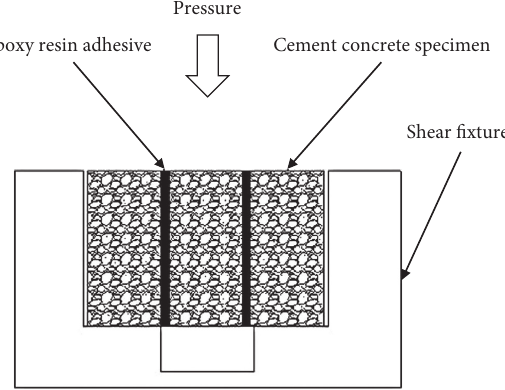
Figure 2: Shear strength test principle. Table 3: Single factor test.